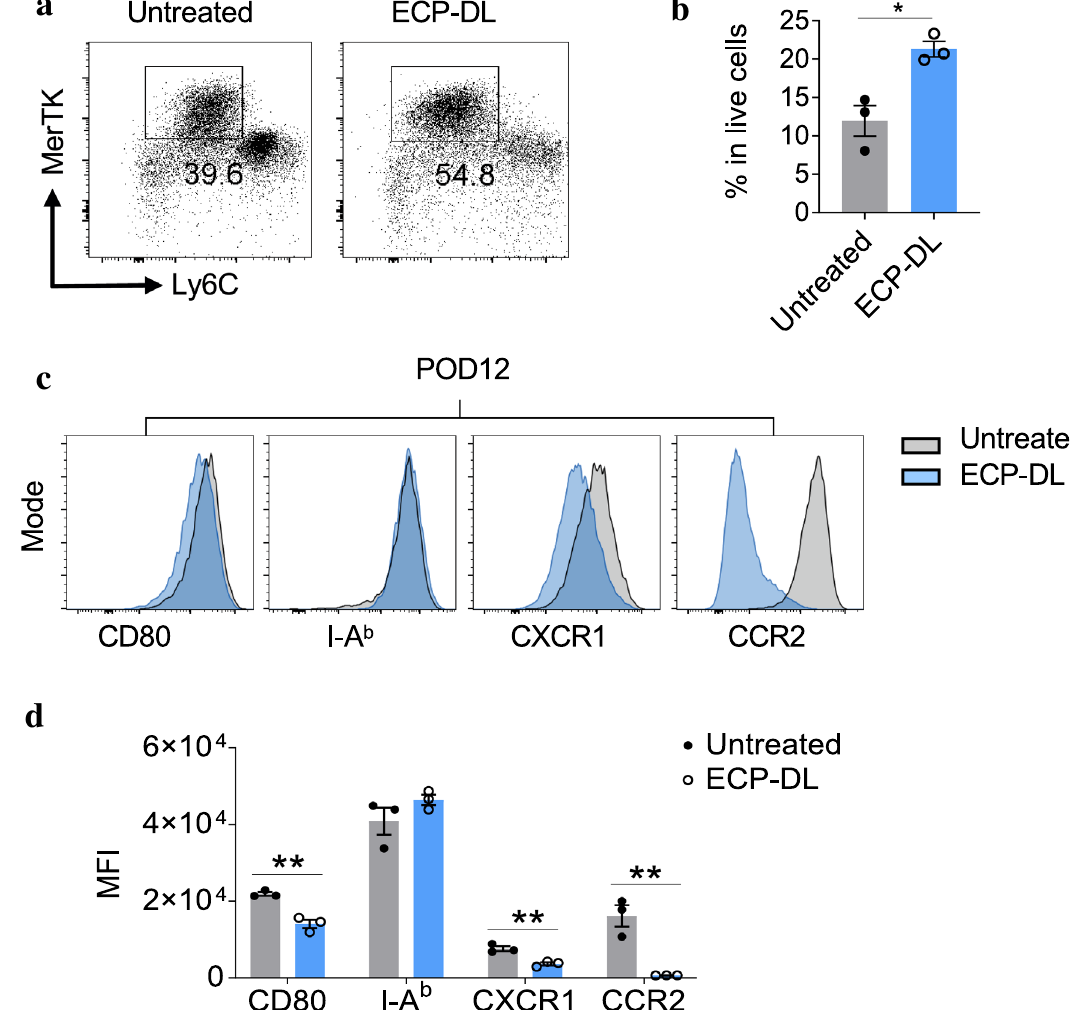
Figure 6. ECP-DL infusion led to an increased accumulation of MerTK-expressing macrophages in allografts. BALB/c to B6 cardiac transplants were performed; animals received ECP-DL on day -7 or no therapy and were sacrificed on POD12. Grafts were harvested and infiltrating cells were subjected to flow cytometry. ( a, b ) Representative flow cytometric plots (gated from H2Db + CD11b + live single cells) with corresponding bar graphs demonstrating higher percentage of MerTK + macrophages in the ECP-DL compared to the untreated group (n = 3/group). * p < 0.05 by student t -test. ( c, d ) Representative histogram (gated from Ly6C low MerTK + population) and corresponding bar graphs, demonstrating the graft-infiltrating MerTK + macrophages had a significant phenotypic difference between the ECP-DL and untreated group. Expression levels of CD80, CXCR1, and CCR2 in MerTK + cells from the ECP-DL group were all significantly lower than those from the untreated group, indicating ECP-DL promotes anti-inflammatory and pro-reparative infiltrates in the allografts. MFI: Mean fluorescence intensity; ** p < 0.01 by student t